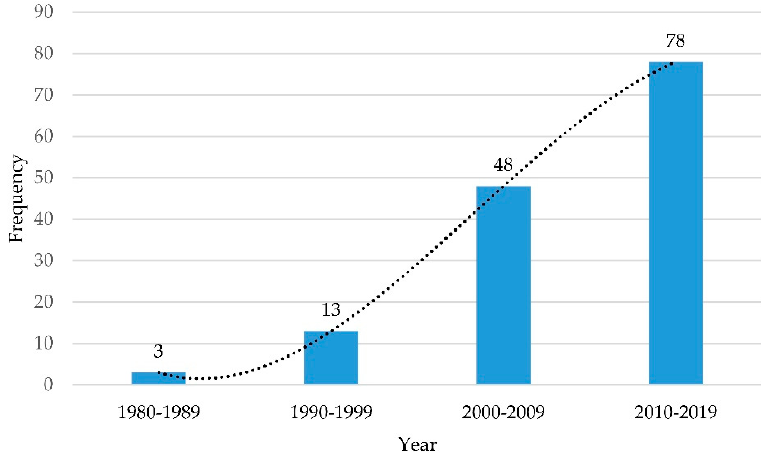
Figure 5. The number of aviation accidents/incidents related to air traffic control (ATC) human factors from 1980 to 2019.